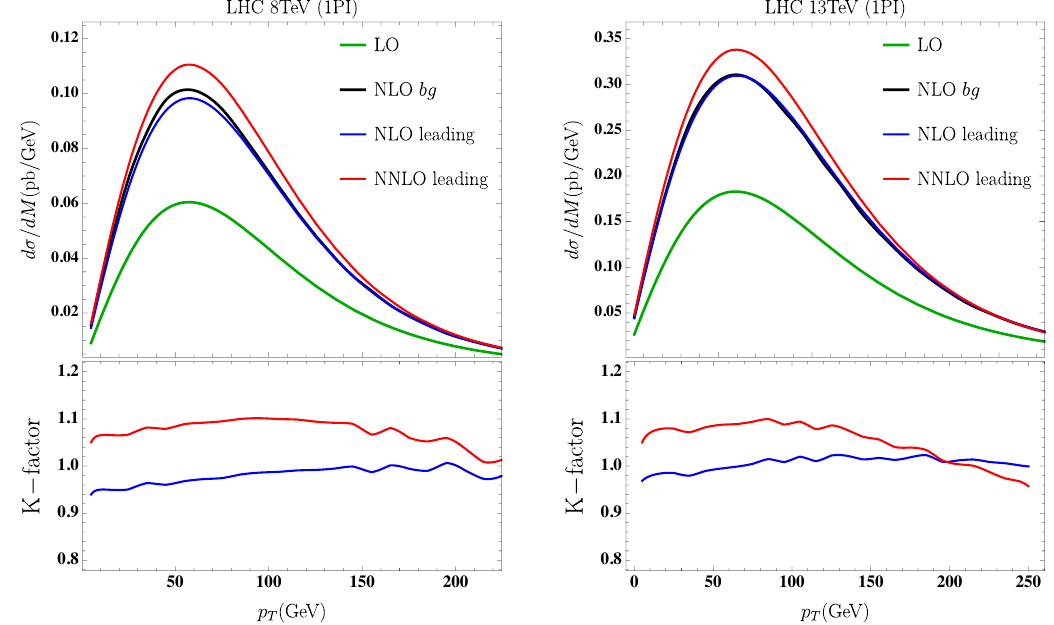
Figure 4 . Top quark p T distributions in the 1PI scheme for tW (cid:0) production. The color scheme is the same as (cid:12)gure 3.